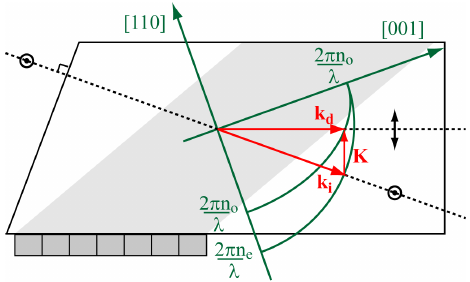
Figure 2. Schematics of the acousto-optic interaction in an AOTF (top view). The gray area depicts the acoustic field created by the piezoelectric transducer bonded to a lateral face of the TeO 2 crystal. The momentum phase matching of the incident ( k i ) and diffracted ( k d ) photons with the acoustic wave ( K ) is represented in the [110] crystallographic frame. The phase matching takes advantage of the medium birefringence: incident and diffracted light beams have or- thogonal polarizations and different propagation directions, which facilitates their selection.